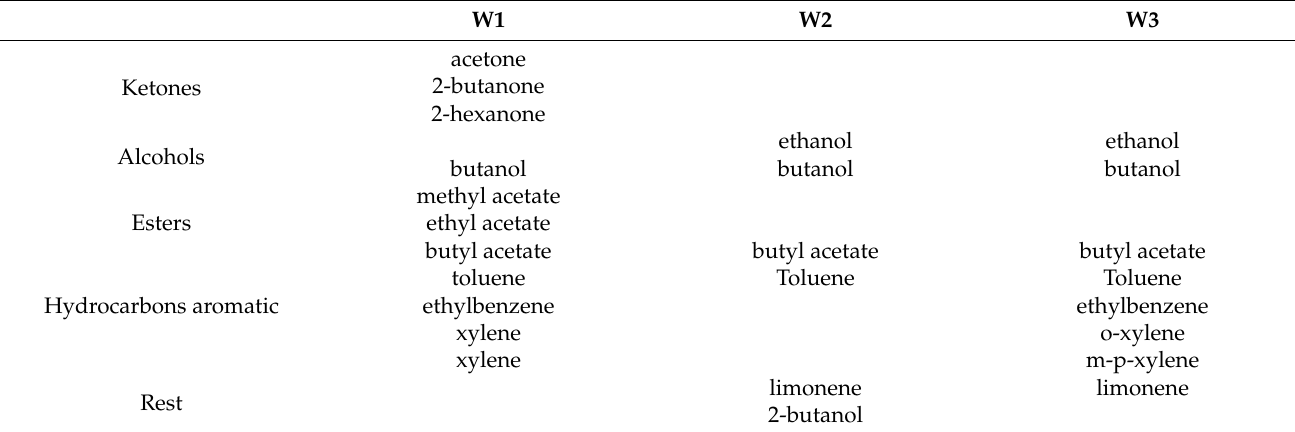
Table 8. Main VOC compounds with the highest concentration detected by GCMS